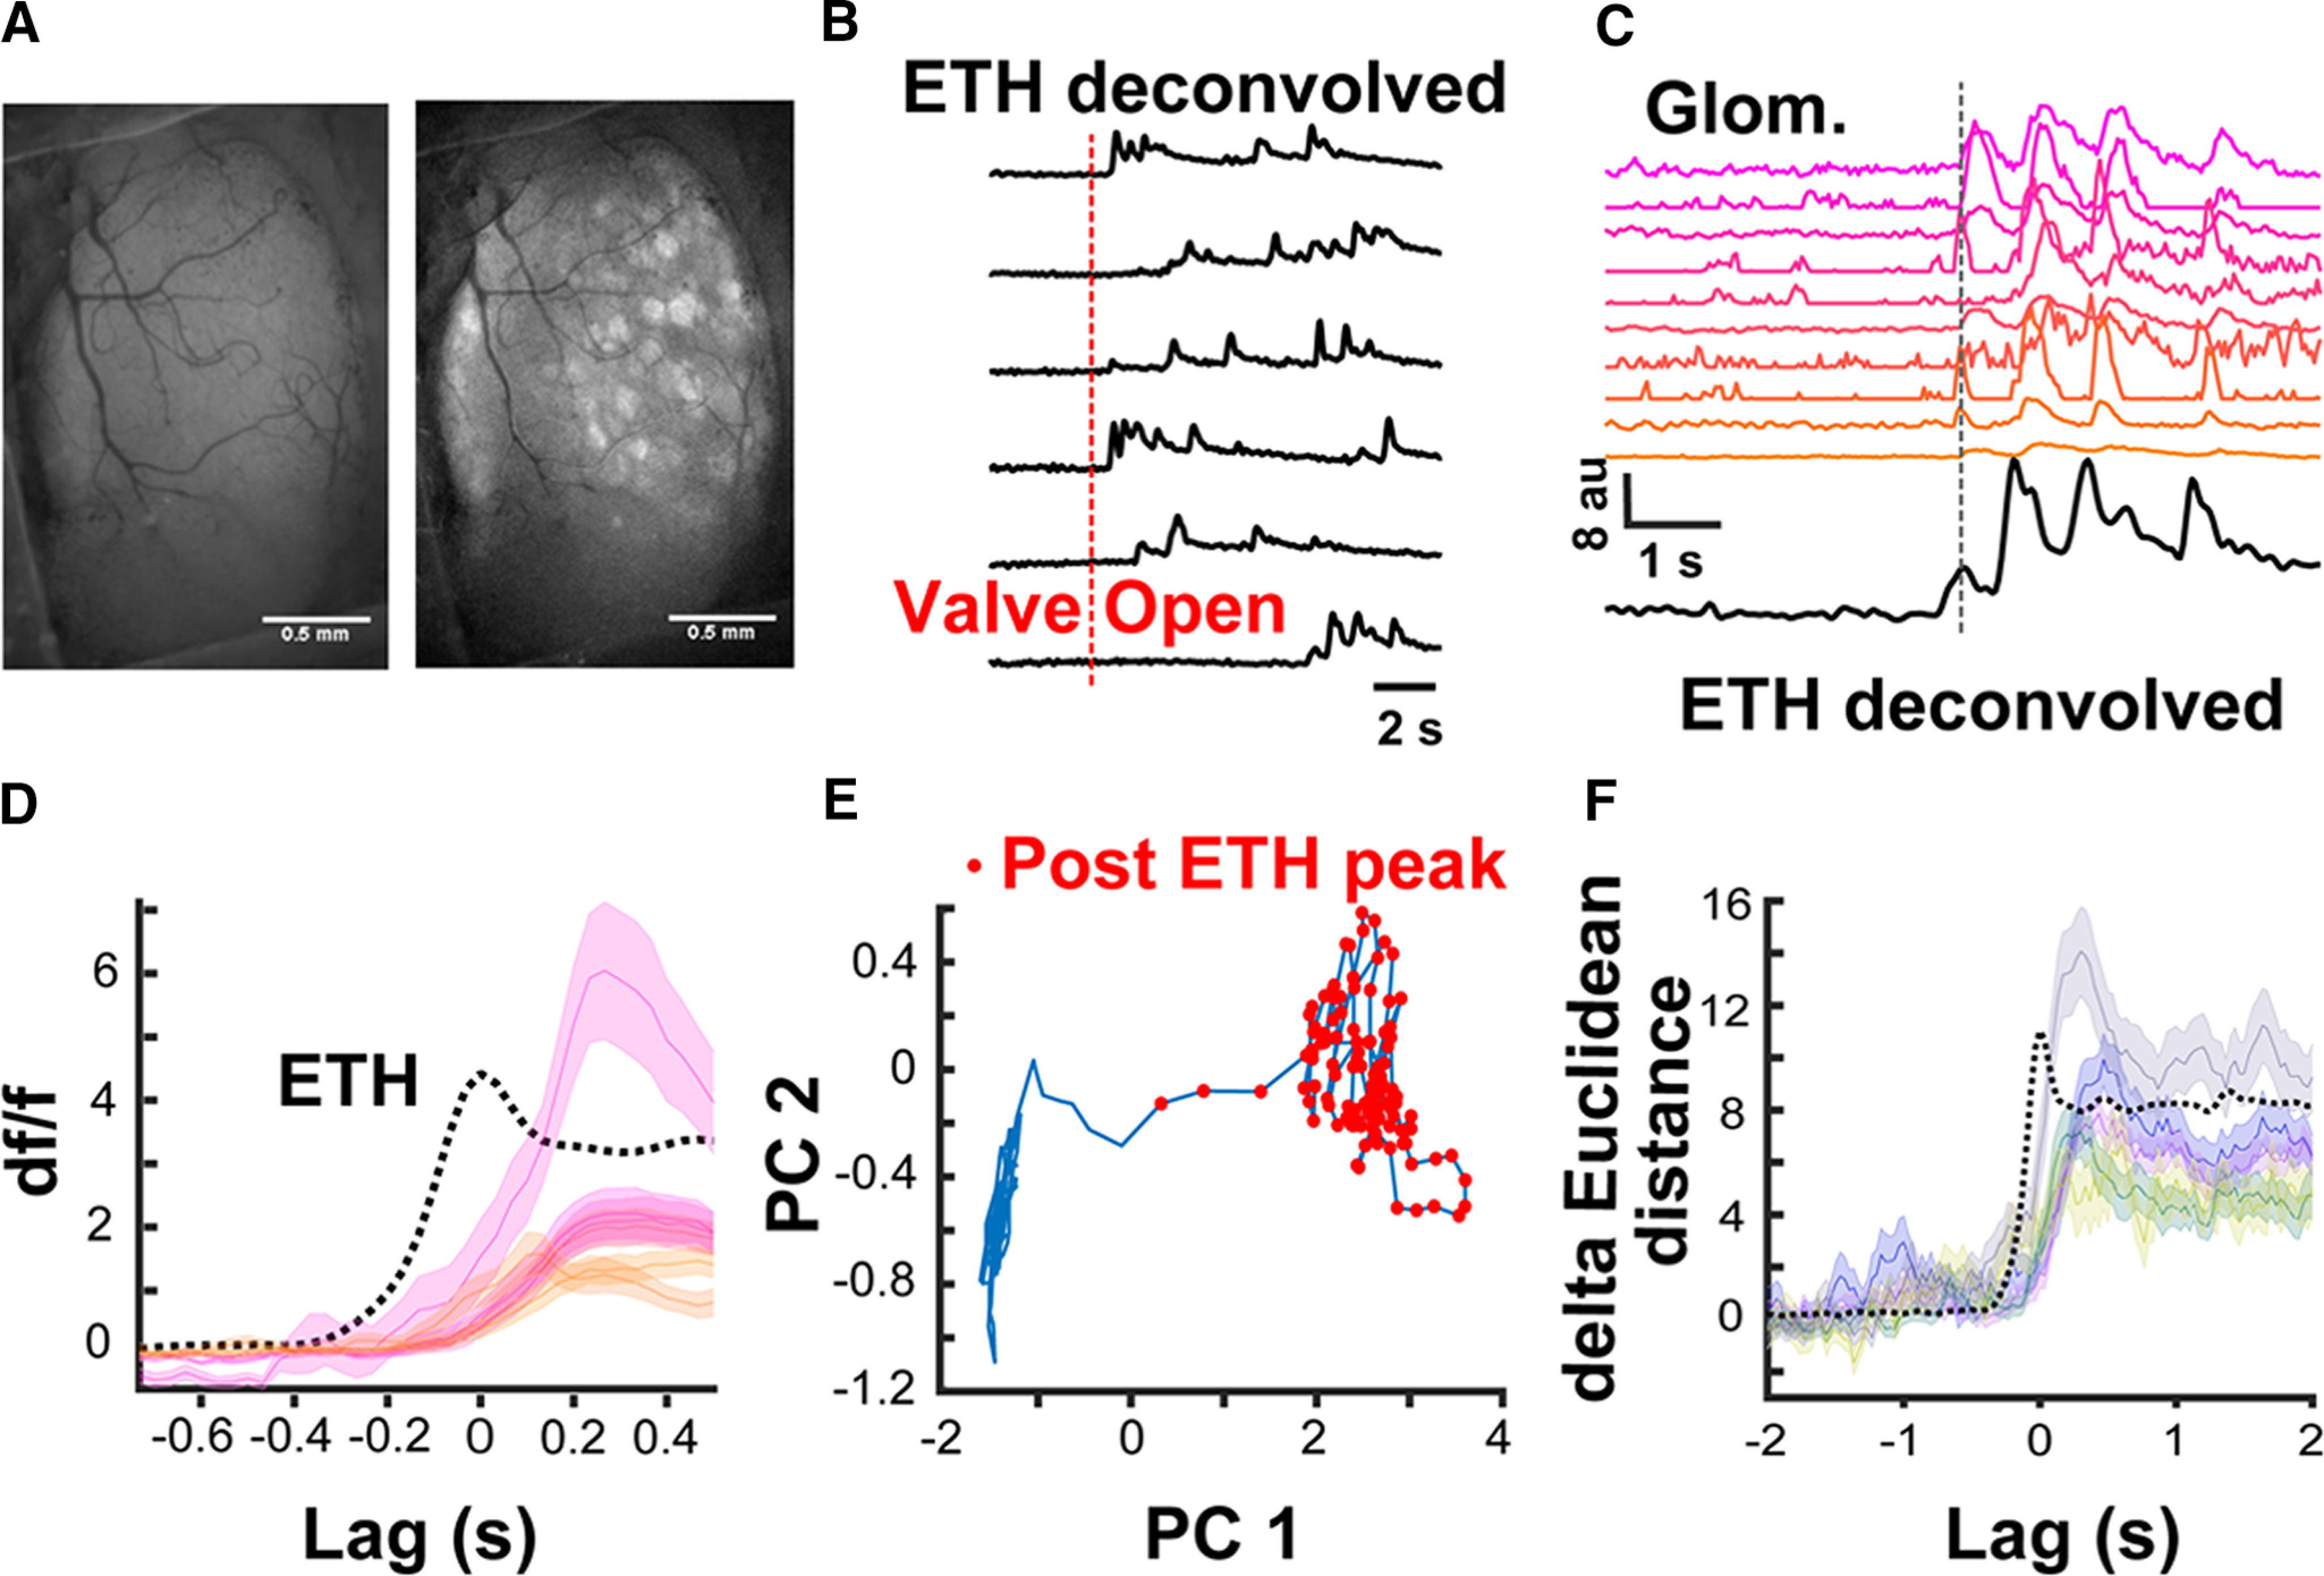
Ethanol plume detected by the ethanol sensor coincide with neural processing in the OB. A, A representative cranial window over the dorsal surface of the OB of a Thy1-GCaMP6f GP5.11 mouse. Left is at rest while right is the SD image after ethanol plume exposure. B, Representative traces showing different times of ethanol plume detection by the sensor after valve opening across six trials. C, Calcium traces from 10 different glomeruli aligned to the first peak of the ethanol plume (dashed line). D, Mean ± SEM traces from six glomeruli averaged over 40 different ethanol plume exposures zoomed in to focus the moment of plume contact. E, Movement in the first two PCs (accounting 48% of the variance) space post ethanol plume exposure from the data presented in C, D. F, Sum of the Euclidean distance from rest across all the PCs aligned to plume detection from five different imaging sessions. Each trace is the mean ± SEM across 40 ethanol plume presentations during each session.